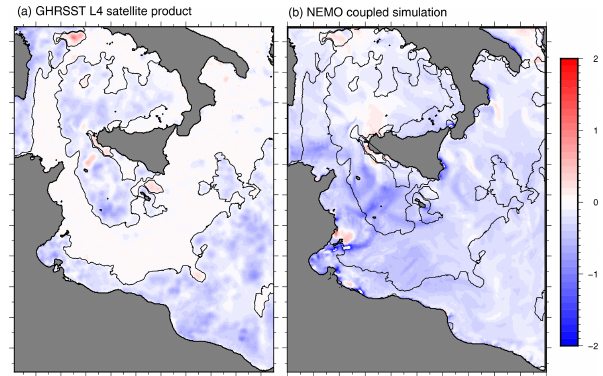
Figure 5. Map of the SST difference after 24h ( ◦ C) in the GHRSST L4 satellite product (a) and in the output of the NEMO simula- tion (b) . The white areas in (a) indicate the lack of satellite ob- servations, which are reported also in (b) for a better comparison.